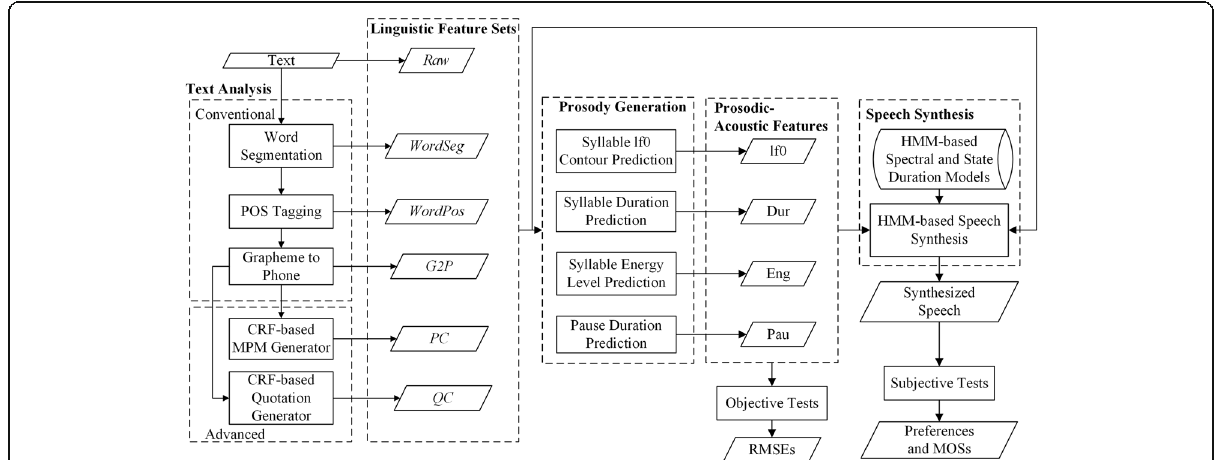
Fig. 12 Flowchart of the prosody generation